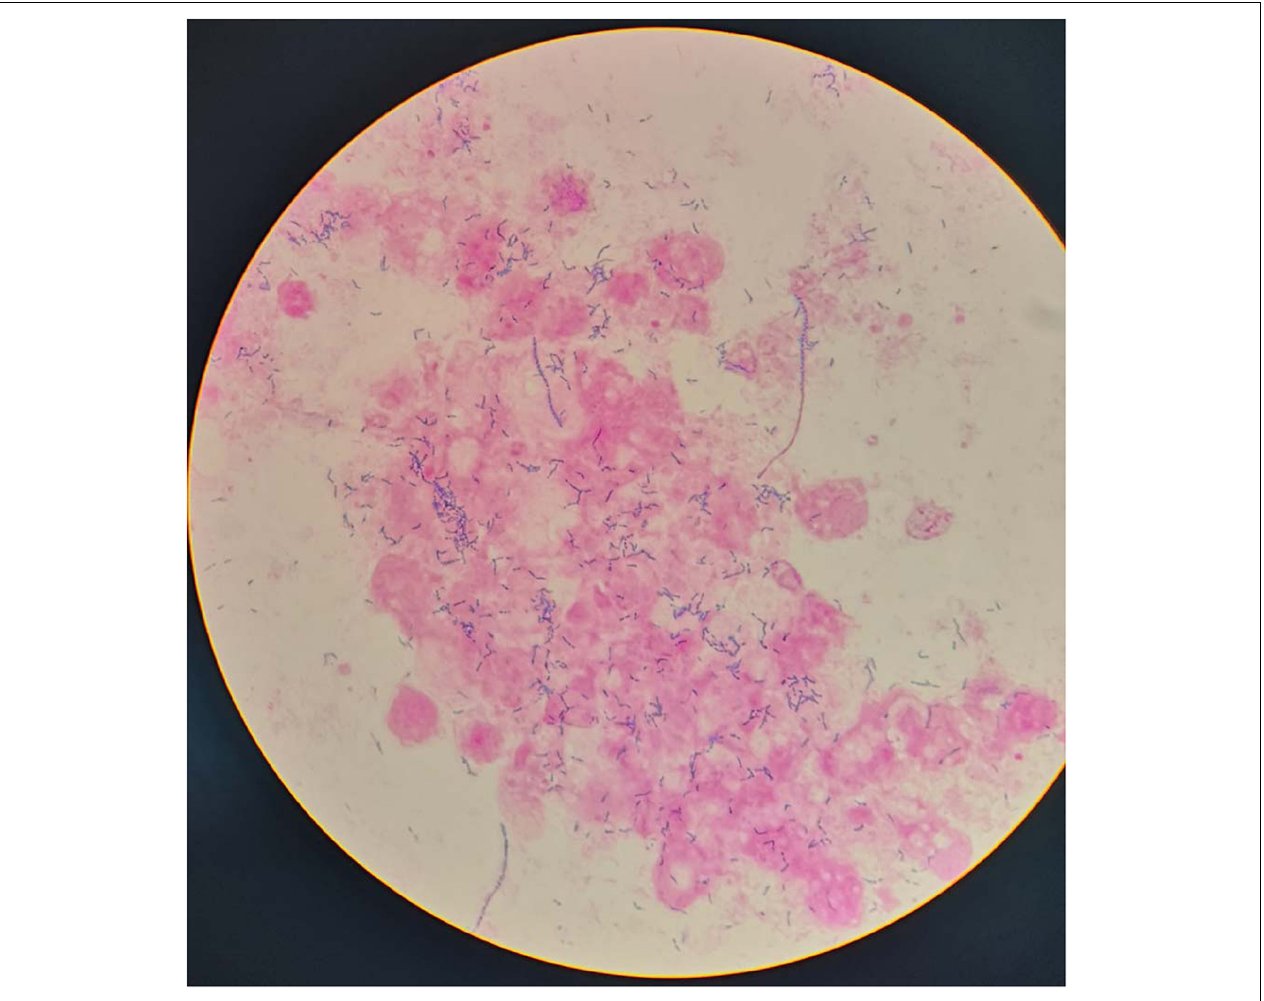
FIGURE 3 | Gram stain of the bronchoalveolar lavage